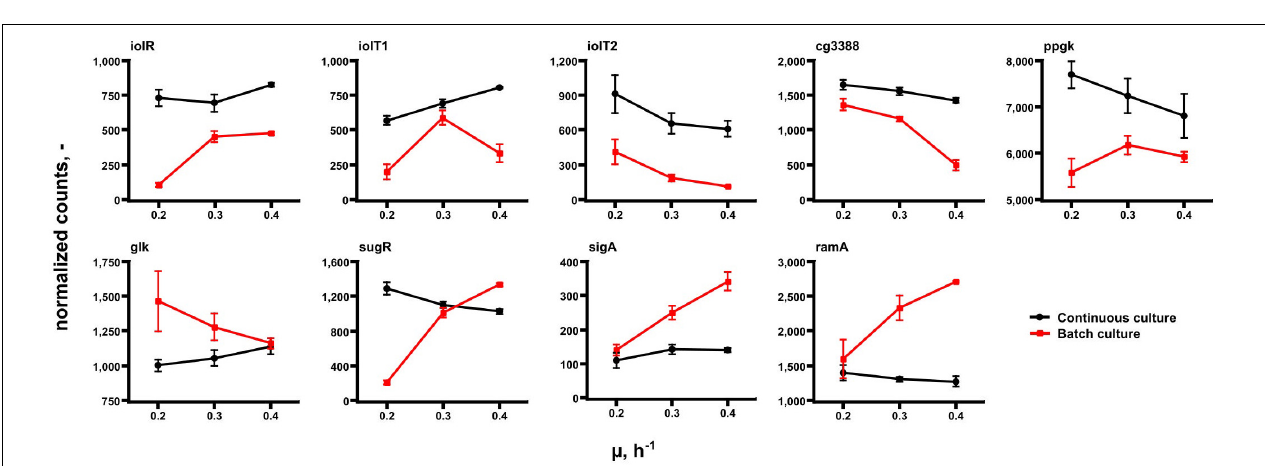
FIGURE 5 | Median expression profiles of differentially expressed genes obtained from transcriptome analysis of C. glutamicum cells grown in chemostat cultivation. A total of 257 genes are grouped in cluster 1 and show an increasing trend, 290 genes are grouped in cluster 2 and show a decreasing expression trend.